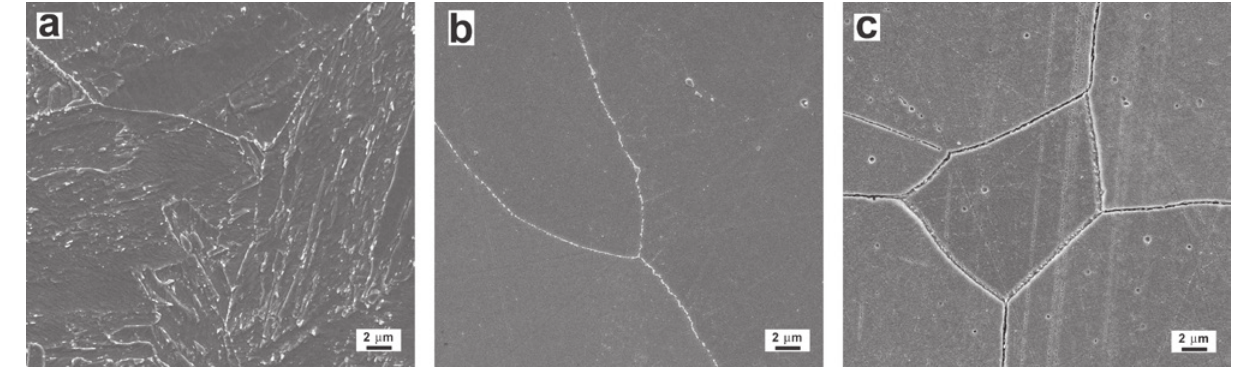
Fig. 2: SEM microstructures of different regions of the dissimilar T91/TP316H welded joint in PWHT state: T91 steel HAZ (a), Ni WM Thermanit Nicro 82 (b), TP316H steel HAZ